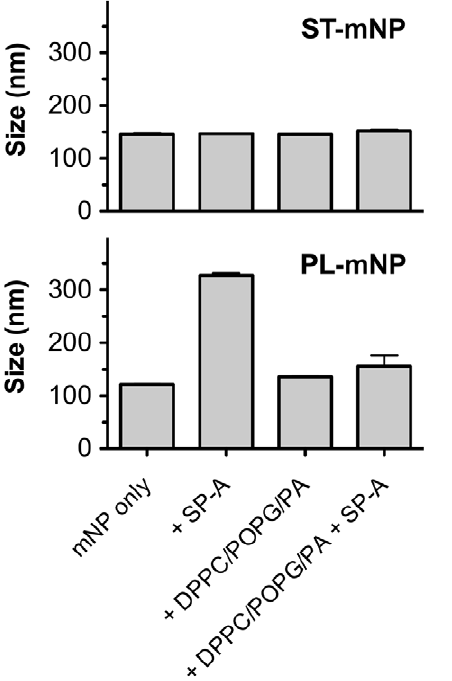
Figure 7. Influence of surfactant lipids on colloidal stability of nanoparticles in presence and absence of SP-A. Starch-modified (ST) magnetite nanoparticles (mNPs; top) or Phosphatidylcholine- modified (PL) mNPs (bottom) were studied in absence (mNP only), or in presence of DPPC/POPG/PA (100 m g/ml total lipids), with or without SP-A (5 m g/ml). Hydrodynamic diameter (Z-average, in nm) was determined subsequently after mixing using dynamic light scattering. Data shown as mean 6 SD (n=3).